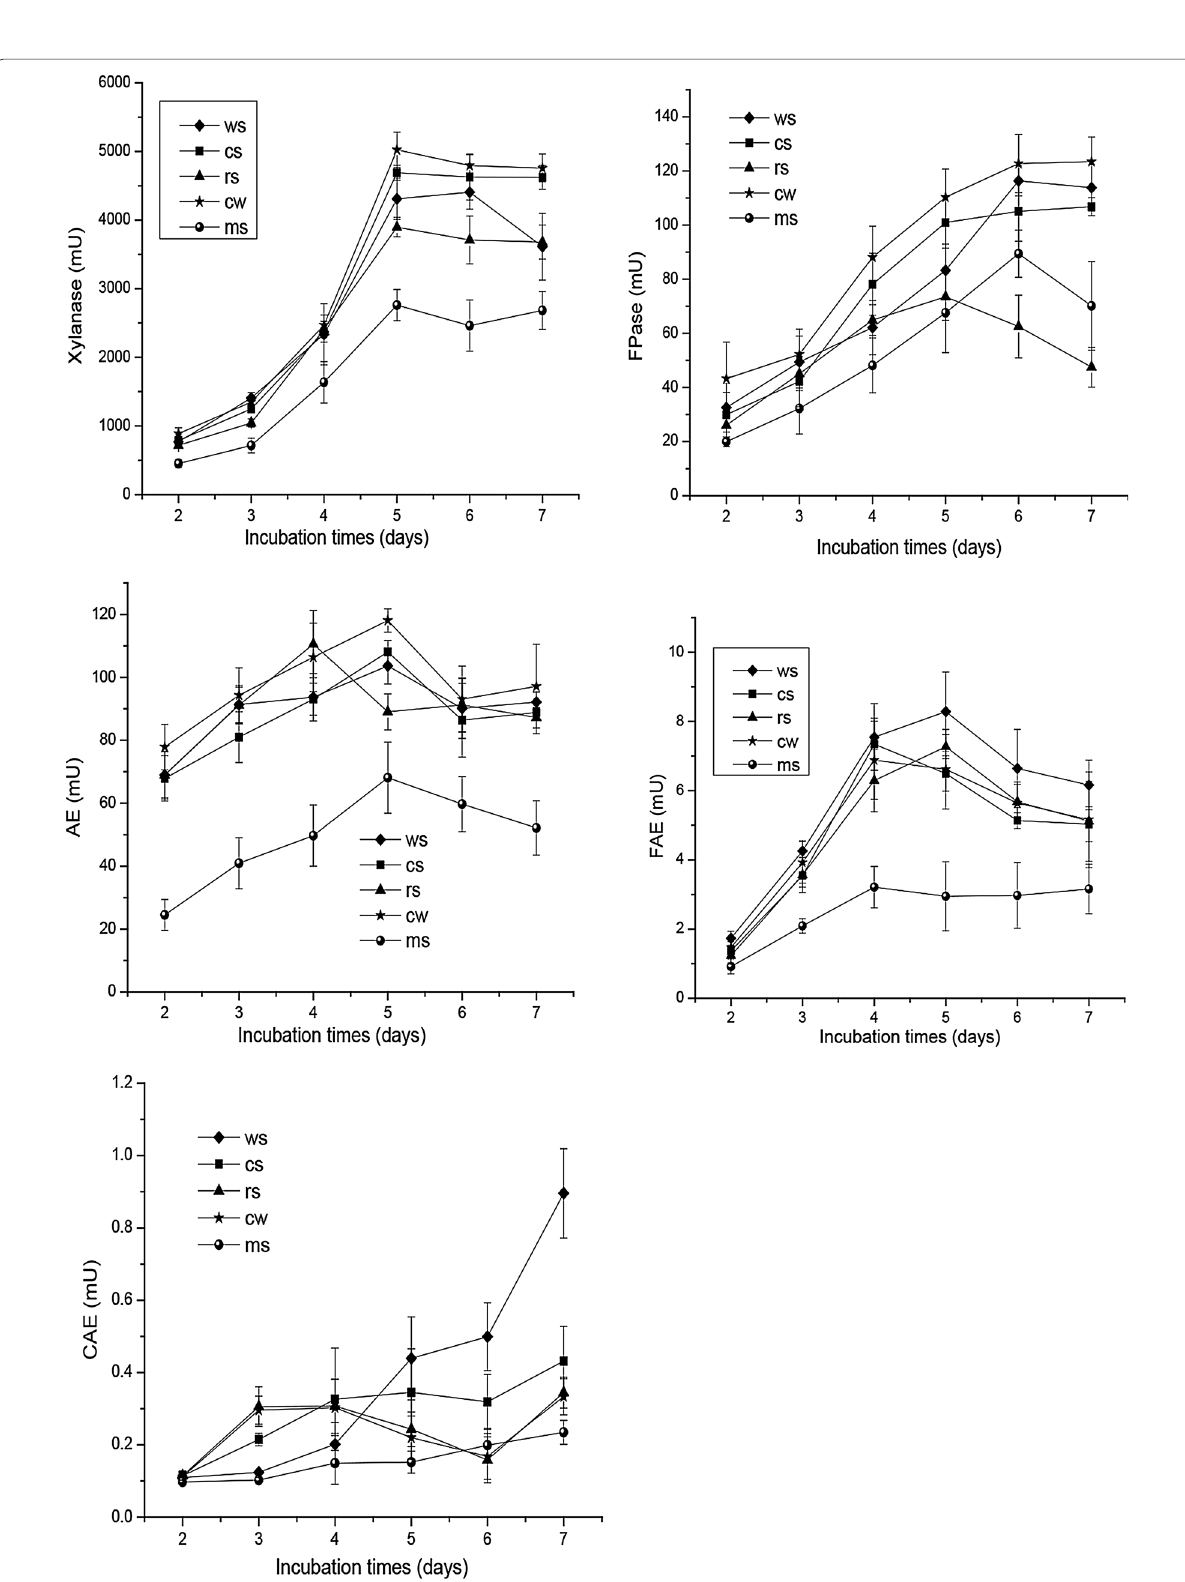
Fig. 5 Fibrolytic profiles of the ( Piromyces M. ruminantium ) Yak‑G18 co‑culture grown on chopped wheat straw, corn stalks, rice straw, Chinese + wildrye and medicago sativa during the 7 days’ incubation ( FPase filter paper ase, FAE ferulic acid esterase, CAE p ‑coumaric acid esterase, AE acetyl esterase, wheat straw diamond , corn stalk square , rice straw triangle , Chinese wildrye star , medicago sativa circle